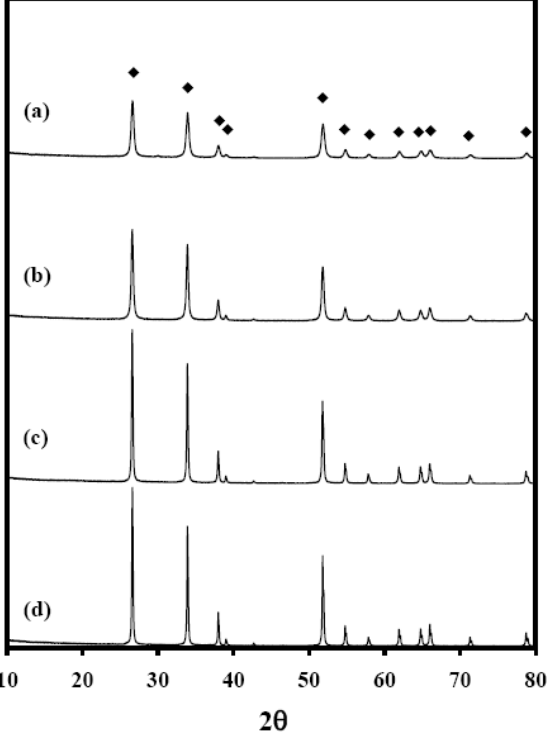
materials calcined at ( a ) 600; ( b ) 800; ( c ) 1,000; and 2 . 2